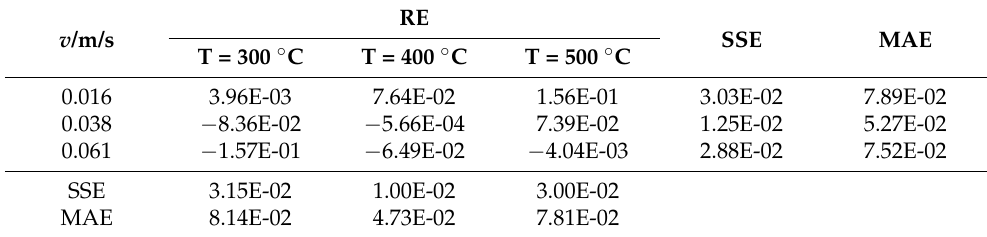
Table 8. The prediction model accuracy of the polynomial model. v /m/s